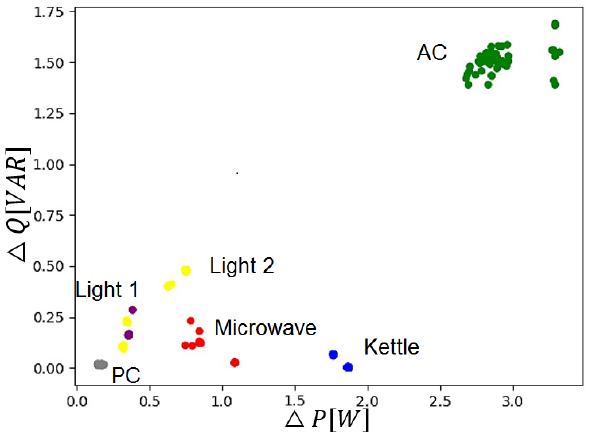
Figure 10. Two-dimensional projection: AC (green), Light 1 (purple), Light 2 (yellow), Kettle (blue), Microwave (red), Computer (gray). Delta P is active power difference, Delta Q is reactive power difference.